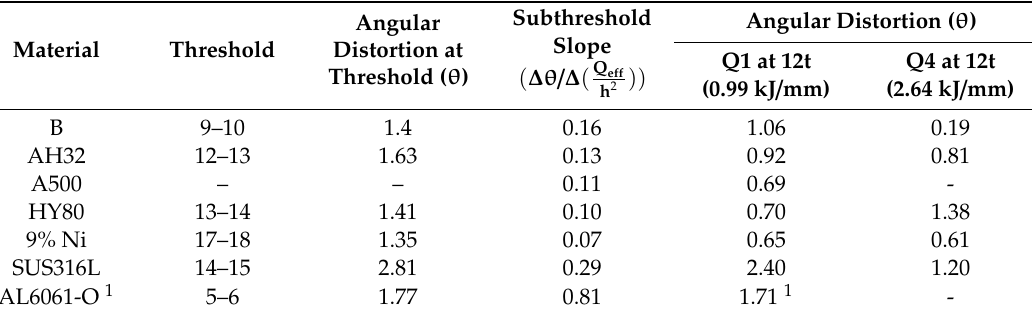
Figure 8. Experimental results: heat input parameter vs. measured angular distortion. Table 6. Angular distortion characteristics of various